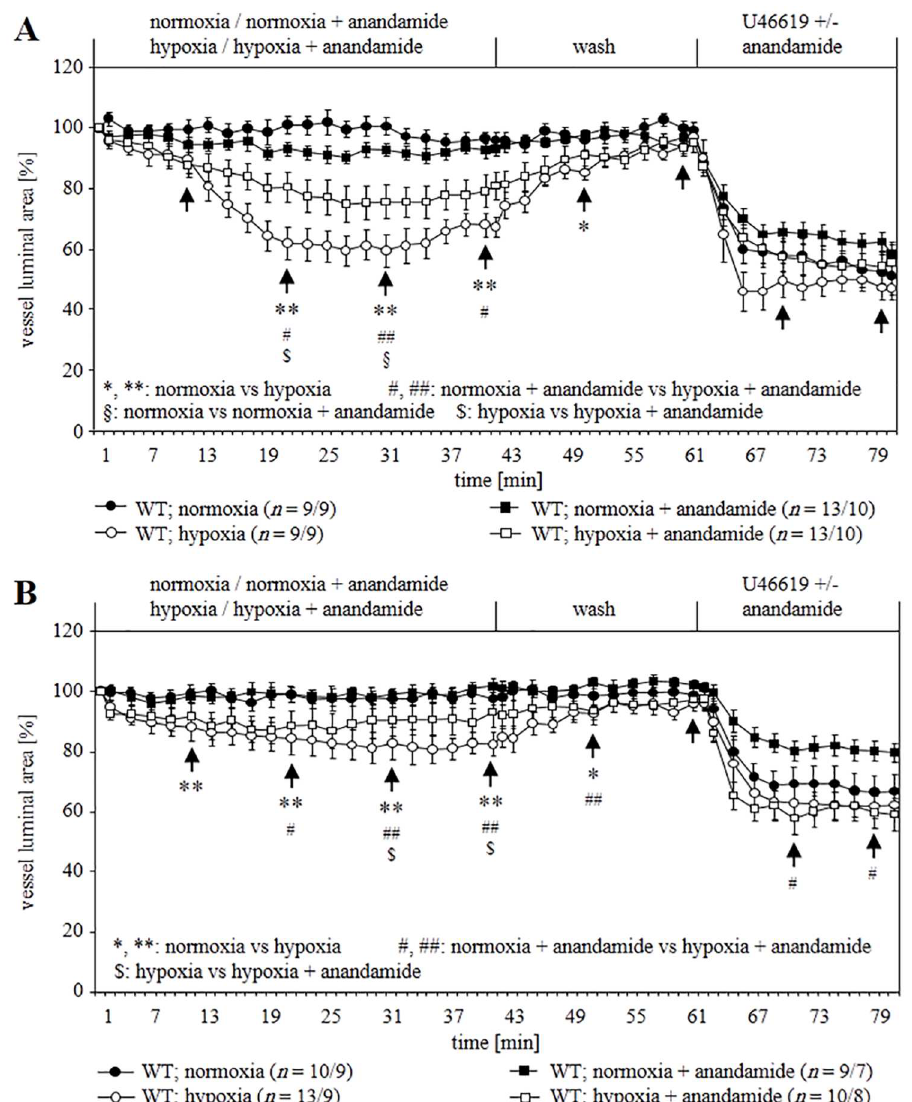
Fig 5. Impact of TASK-1 inhibitor anandamide on vasoconstriction of WT mice. (A) Effect of anandamide on intra-acinararteries. Anandamide inducedconstriction at normoxiaand reducedhypoxia- inducedvasoconstriction significantly at one time. (B) Effect of anandamide on pre-acinararteries. Anandamide did not induce constriction at normoxia. However, it reducedhypoxia-induced vasoconstriction significantly after 20 min. Data are presentedas mean ± SEM. n is number of vessels/number of animals. Tests of significancewere done at the time points indicatedby arrows. * , #, §, $ P (cid:20) 0.05 and ** , ## P (cid:20) 0.01 (Mann–Whitney